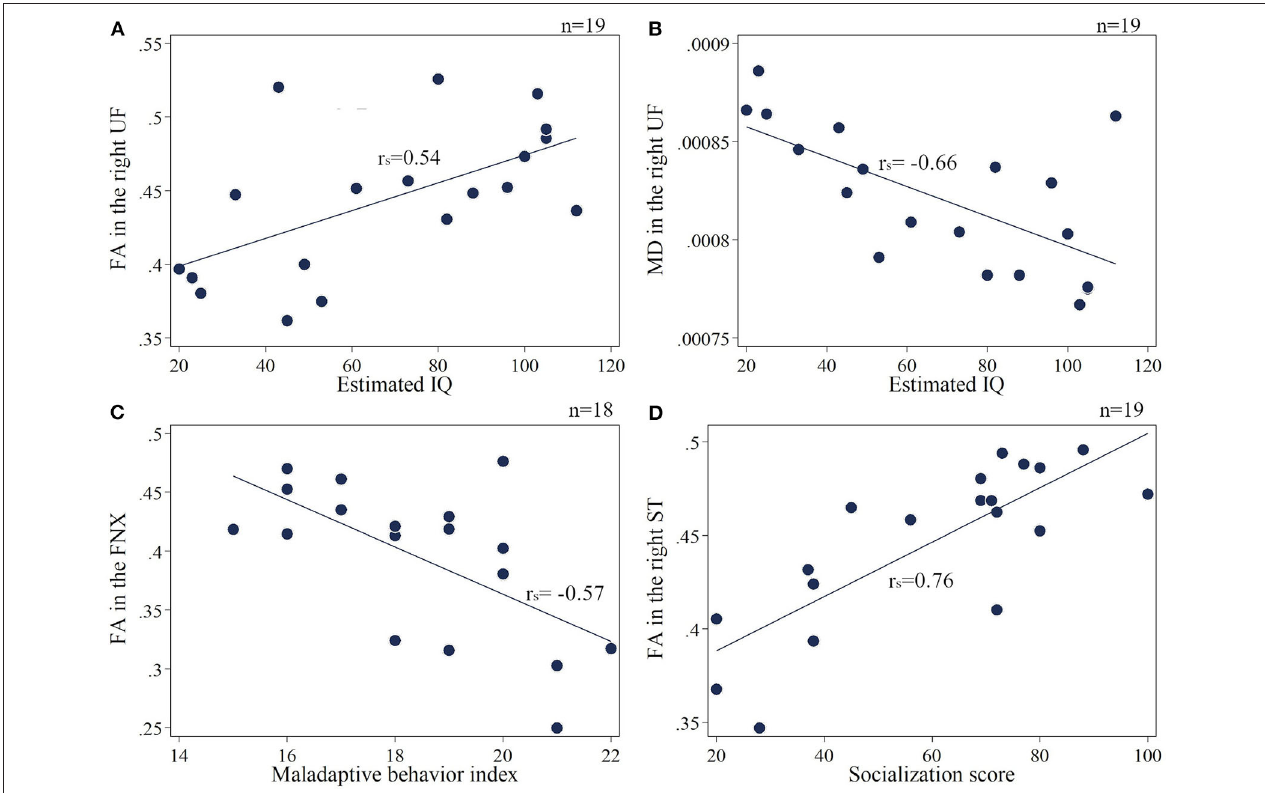
FIGURE 3 | (A,B) Correlation of the estimated IQ and FA/MD in the right UF. (C) Maladaptive behavior index negatively correlates with FA in the FNX. (D) Socialization score positively correlates with FA in the right ST. UF, uncinate fasciculus; FNX, body of the fornix; ST, stria terminalis.